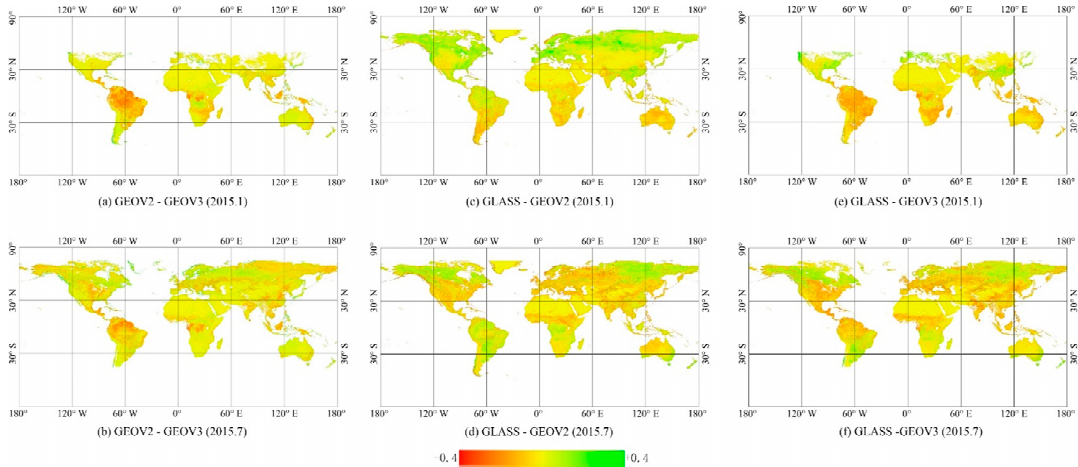
Figure 2. Difference maps among GEOV2, GEOV3, and GLASS FVC products in January ( top ) and Figure 2. Di ff erence maps among GEOV2, GEOV3, and GLASS FVC products in January ( top ) and July ( bottom ), 2015. July ( bottom ),